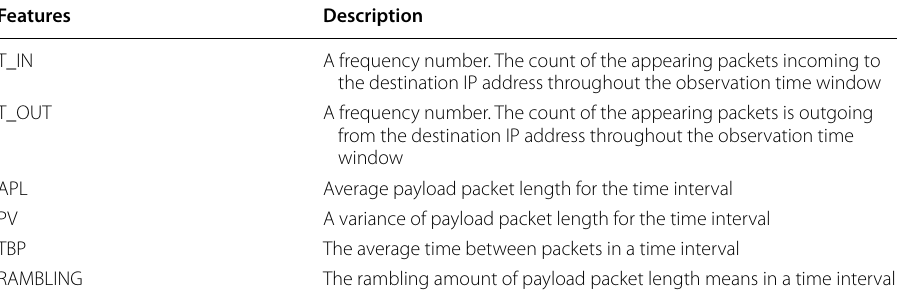
Table 2 Extracted features (calculated) of interval time Features